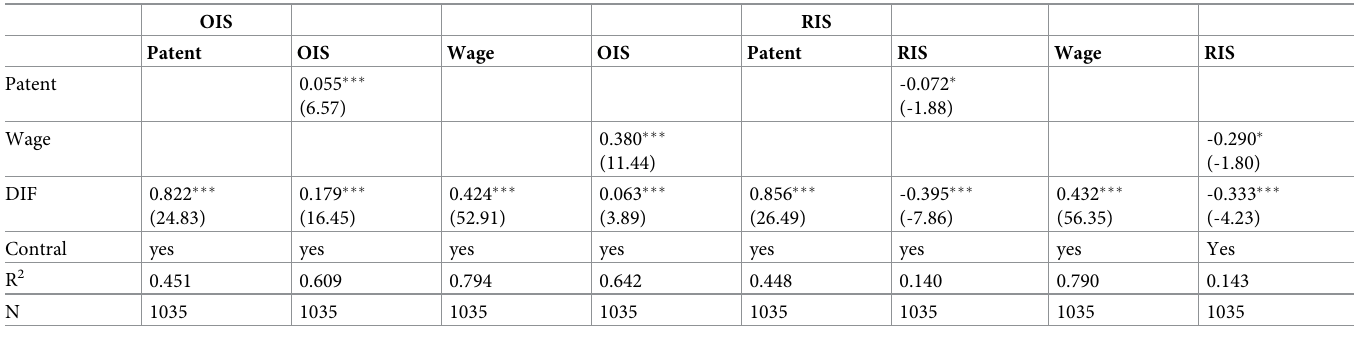
Table 7. Estimated results of mediating variable